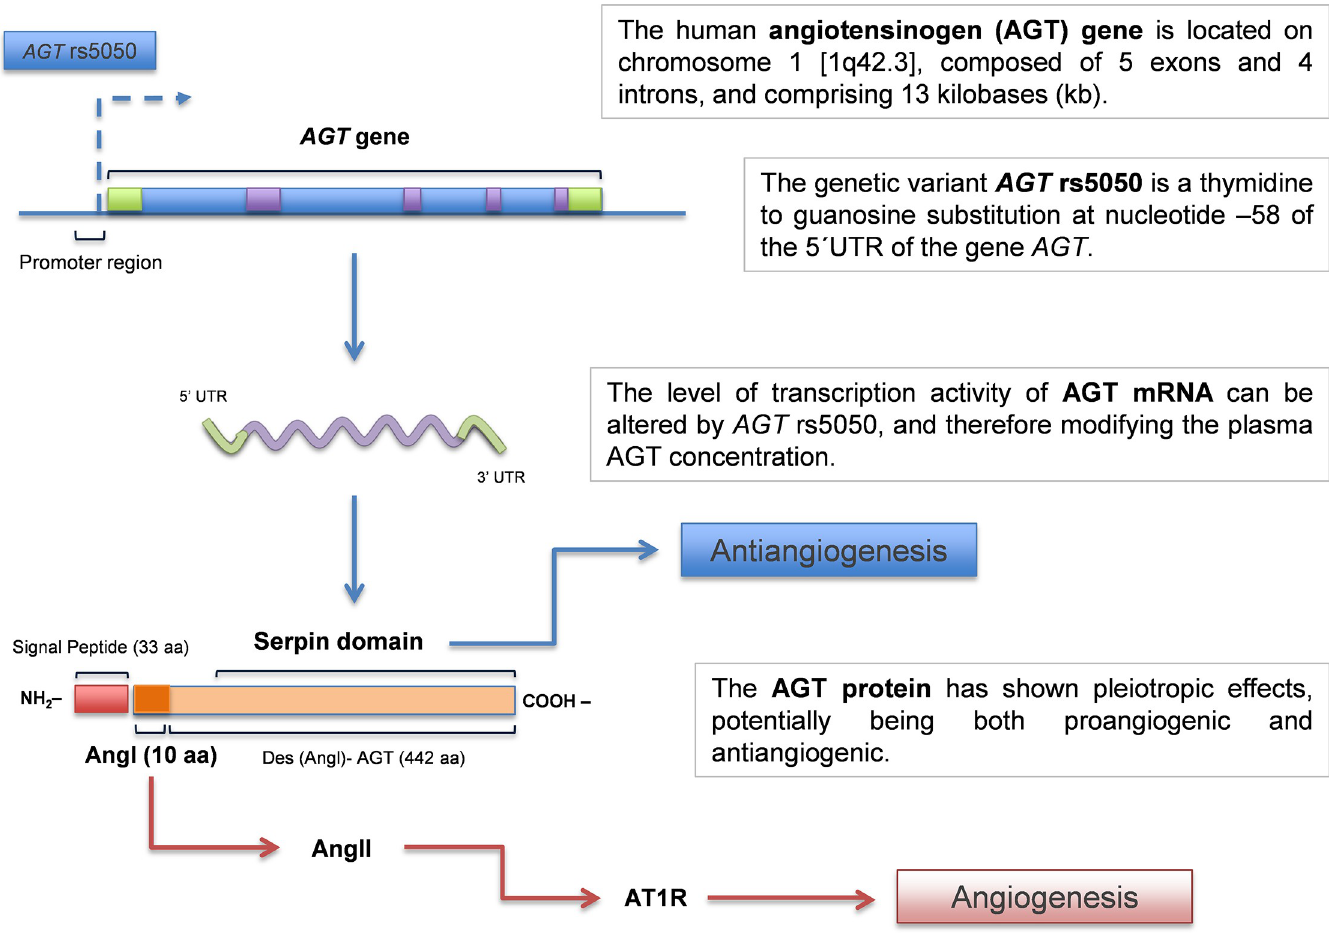
Fig 2. Hypothetical dual mechanism of the AGT rs5050 genetic variant. The 5´ upstream core promoter region of the human AGT gene, where rs5050 is identified, has been recognized as an authentic regulator for the transcription of AGT mRNA [38]. Differences in the AGT plasma levels were found between the genotypes of rs5050, with the GG-genotype associated with the lowest levels [22]. AGT expresses opposite effects, showing an antiangiogenic property, such as some Serpins family members, and a proangiogenic activity as the precursor of AngII. It might depend upon local conditions that define which of the effects dominates